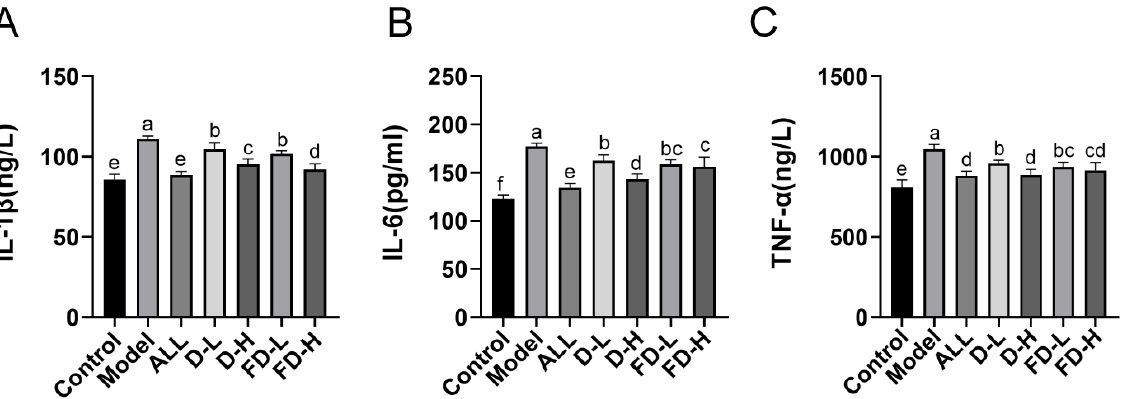
Figure 4. Effects on the levels of inflammatory factors IL-1 β , IL-6, and TNF- α in mice with Figure 4. E ff ects on the levels of in fl ammatory factors IL-1 β , IL-6, and TNF- α in mice with HUA. ( A )Serum IL-1 β level; ( B )Serum IL-6 level; ( C )Serum TNF- α level. The data are expressed as mean ± SD (n = 8). Di ff erent lowercase le tt ers indicate statistically signi fi cant di ff erences ( p < 0.05) between the groups. ALL, allopurinol; D-L, dandelion low dose group; D-H, dandelion high dose group; FD- L, low dose group of LAFD; FD-H, high dose group of LAFD.